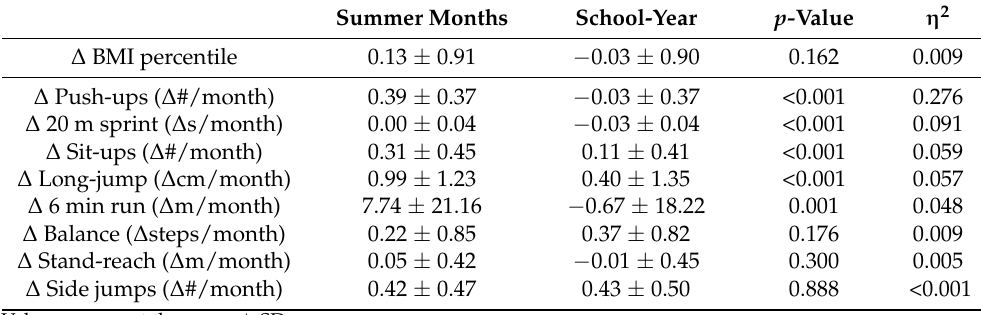
Table 3. Changes in BMI percentile and physical fitness during the school year and the summer months.